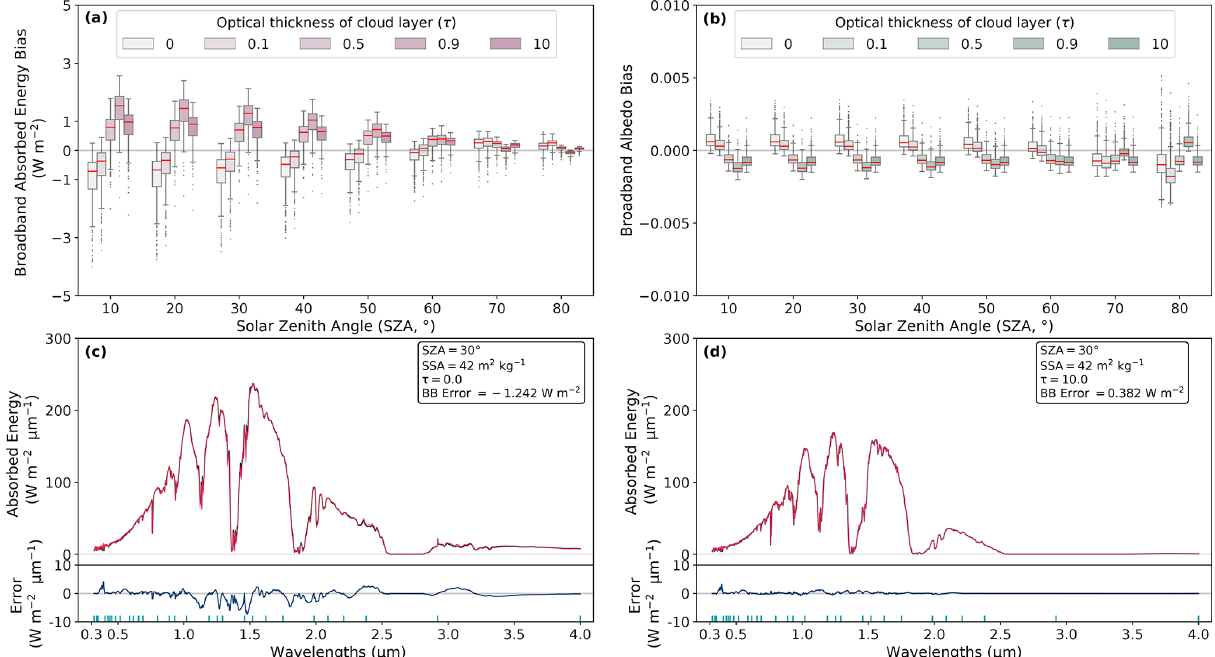
Figure 3. Bias on the broadband absorbed energy (a) and on the broadband albedo (b) as a function of the SZA and τ . The biases are calculated for all the simulations described in Sect. 2.2.3 between the absorbed energy calculated by the method and the reference absorbed energy calculated by TARTES–SBDART. The red lines indicate the median (same as in Fig. 2), the box shows the 25th to 75th percentiles, and the whiskers show the 5th to 95th percentiles. Example of absorbed energy profiles for a snowpack without LAPs as a function of wavelength calculated for an SZA of 30 ◦ and a τ value of 0 (clear sky, c ) as well as a τ value of 10 (full overcast, d ). The black lines represent the absorbed energy calculated by TARTES–SBDART at 1nm resolution, and the red lines represent the absorbed energy calculated by VALHALLA. In blue, the errors on the absorbed energy for these same simulations are shown as a function of wavelength. The green vertical lines represent the TPs used in VALHALLA. BB error corresponds to the broadband error for the absorbed energy in panels (c) and (d) .